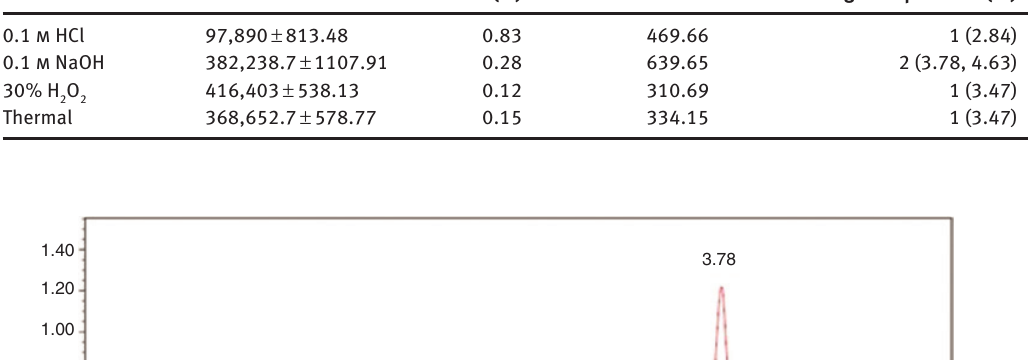
Table 5: Forced degradation studies of rosuvastatin at various stress conditions (n = 3). Stress